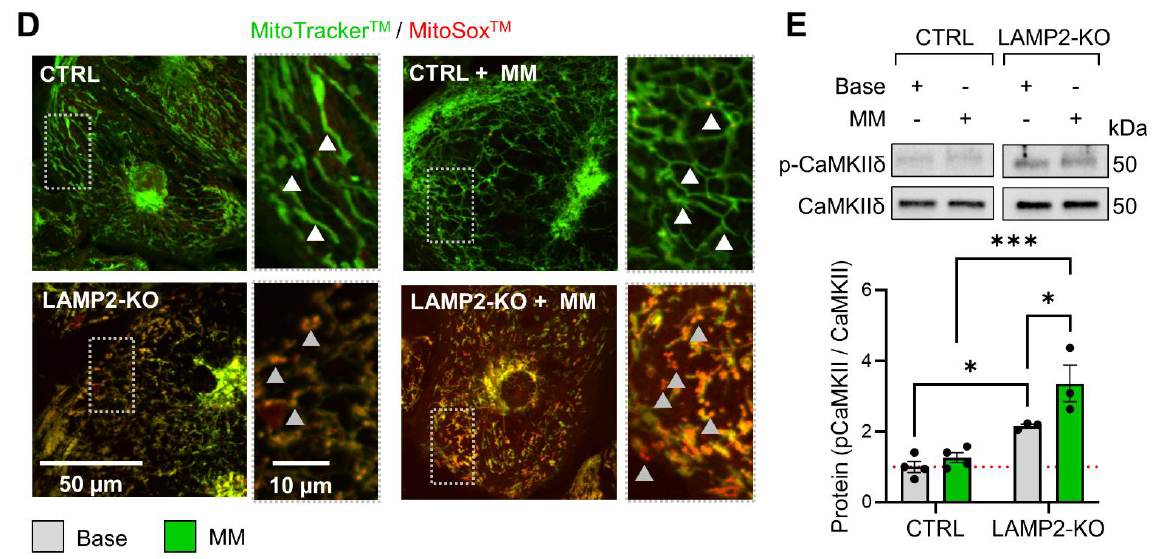
Figure 6. ROS overload led to over-activation of CaMKII in LAMP2 KO iCMs after MM treatment. ( A ) Western blot quantification of LC3-I and LC3-II expression in Ctrl and LAMP2 KO iCMs. Impaired autophagic flux is evidenced by the significantly increased LC3-II/I ratio, as the degradation mechanism of LC3-II is compromised in LAMP2 KO both before and after MM treatment. Results from at least 4 independent experiments; ( B ) Representative images of Hoechst and CellRox TM staining of cellular ROS levels; ( C ) Quantitative results showed increased ROS level in LAMP2 KO and LAMP2 KO + MM groups. N = 147, 167, 182, and 136 cells in Ctrl, LAMP2 KO, Ctrl + MM, and LAMP2 KO + MM group from at least 3 independent experiments. ns: no significance; ( D ) Representative images of MitoTracker TM green and MitoSox TM red co-staining of mitochondrial morphology and mROS levels. Rectangular images showed zoom-in views of the dashed boxes. White arrows indi- cate the mitochondrial networks. Grey arrows indicate fragmentized mitochondria with increased mROS levels; (E) Western blot quantification of the expression and phosphorylation levels of cardiac CaMKIIδ. The p - CaMKIIδ/CaMKIIδ ratio is significantly increased in LAMP2 KO and LAMP2 KO + MM groups. Results from at least 3 independent experiments. Red dashed line indicates the value in Ctrl group at base level were normalized to 1. * p <0.05, ** p < 0.01, *** p < 0.001, and **** p < 0.0001 by two-way ANOVA test followed by Holm – Sidak method.